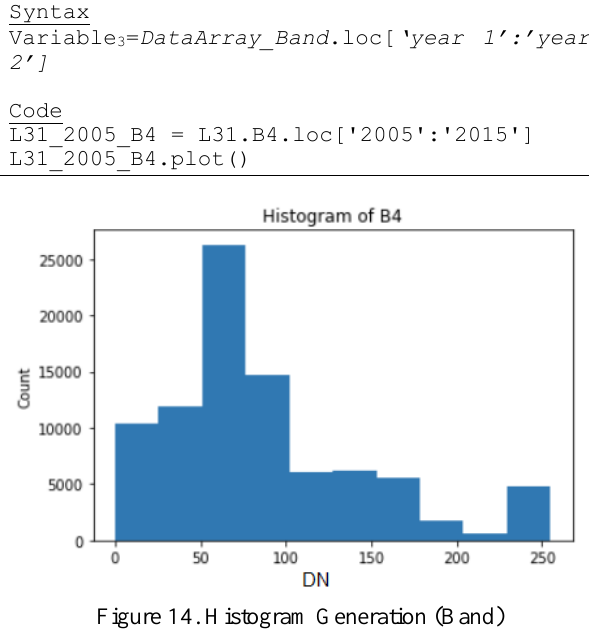
Figure 14. Histogram Generation (Band)